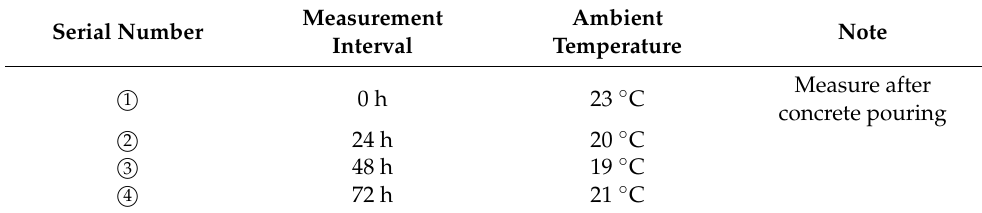
Table 3. Measurement interval and ambient temperature